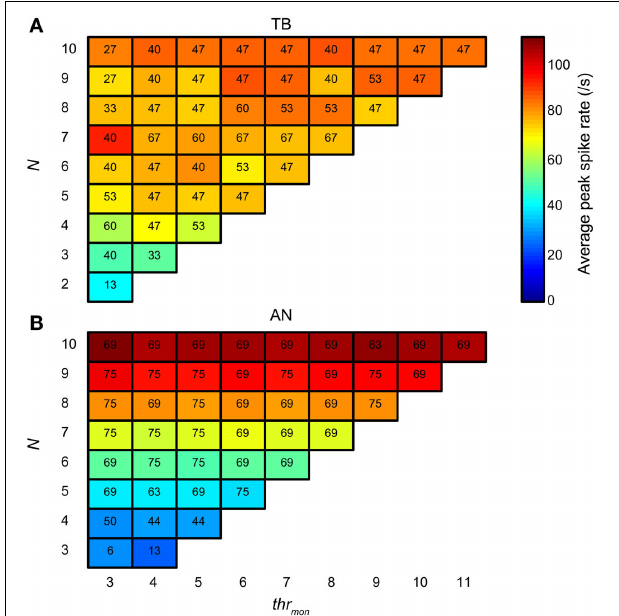
FIGURE 15 | Average NDF modulation depth for TB (A) and AN (B) simulations. The color of each subplot indicates the average peak rate for accepted simulations with thr mon value and N indicated by the abscissa and ordinate. cw = 50 μ s, and thr bin = 2. Color scale is the same in (A) and (B) . The number in each subplot indicates which proportion (in %) of the individual datasets had at least one accepted simulation for that combination of